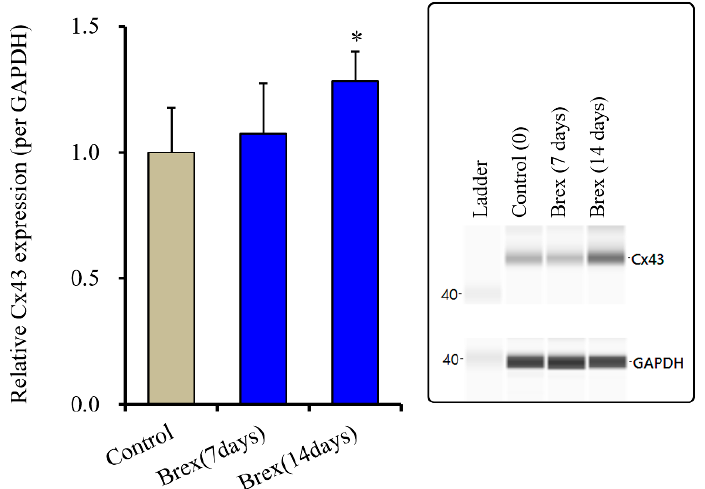
Figure 5. Effects of subchronic administration (7 and 14 days) of therapeutic relevant concentration of Brex (300 nM) on protein expression of connexin43 (Cx43) in the cytosol fraction of cortical primary cultured astrocytes. In left side histograms, ordinate: mean ± SD ( n = 6) of the relative protein level of Cx43 per GAPDH. * p < 0.05: relative to control (Brex-free) by one-way ANOVA with Tukey’s post-hoc test. Right side panels indicate their pseudo-gel images using capillary immunoblotting.